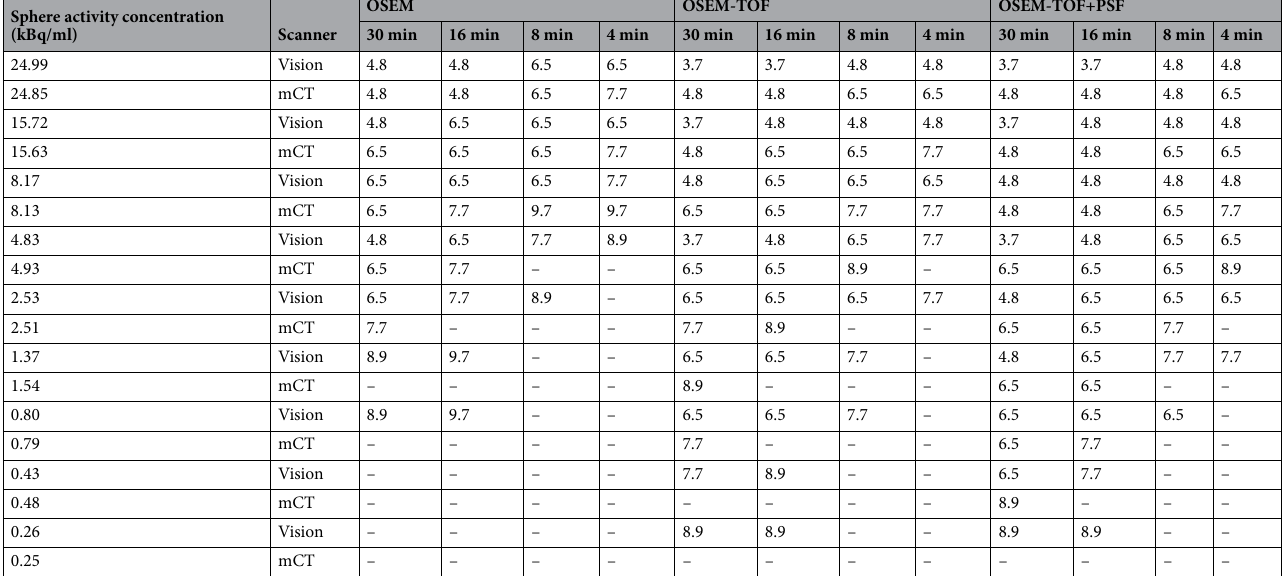
Table 3. Human observer study results—smallest detected sphere size (in mm) for each scanner type, reconstruction algorithm and emission